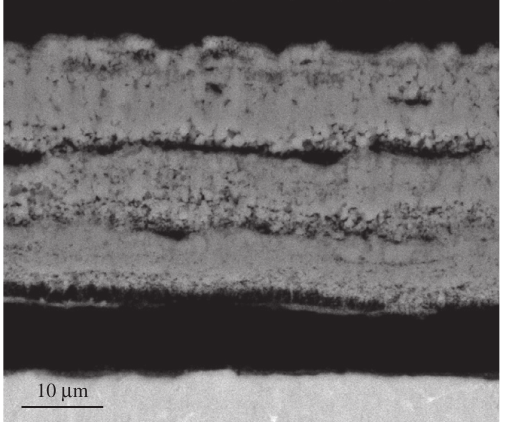
Figure 8: Micrograph (SEM/BEI) of a cross section of Ti-6Al-4V oxidized in air at 750°C for 24